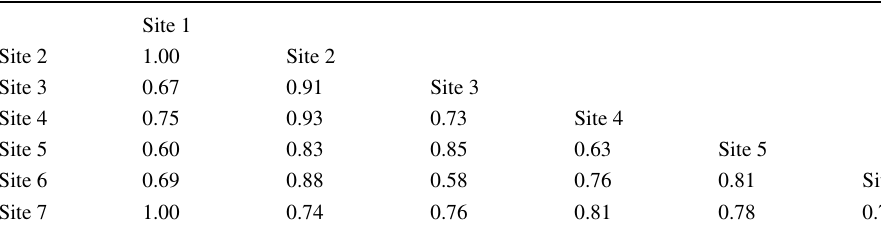
Fig. 4 Individual-based rarefac- tion curves calculated on the basis of seven study sites under